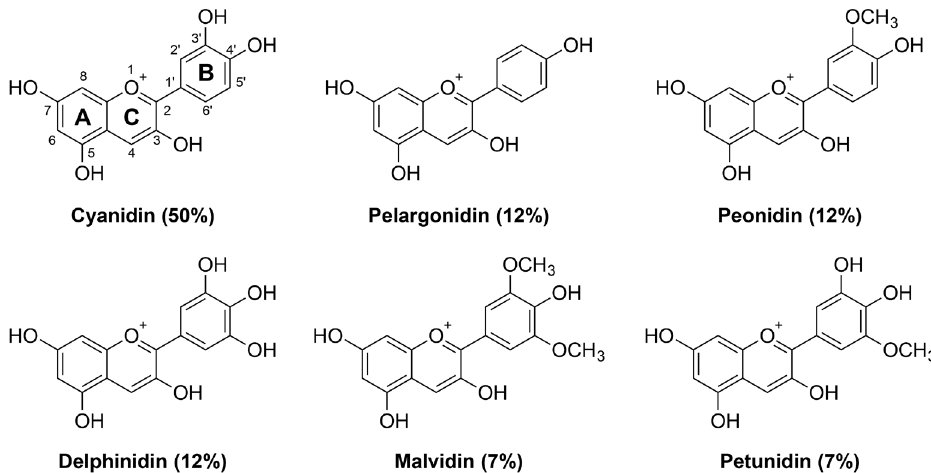
Figure 1 - The six most common chemical structures of anthocyanins, shown as the fully deglycosylated or aglycone forms referred to as anthocyanidins; the percentages in parentheses represent the approximate relative natural